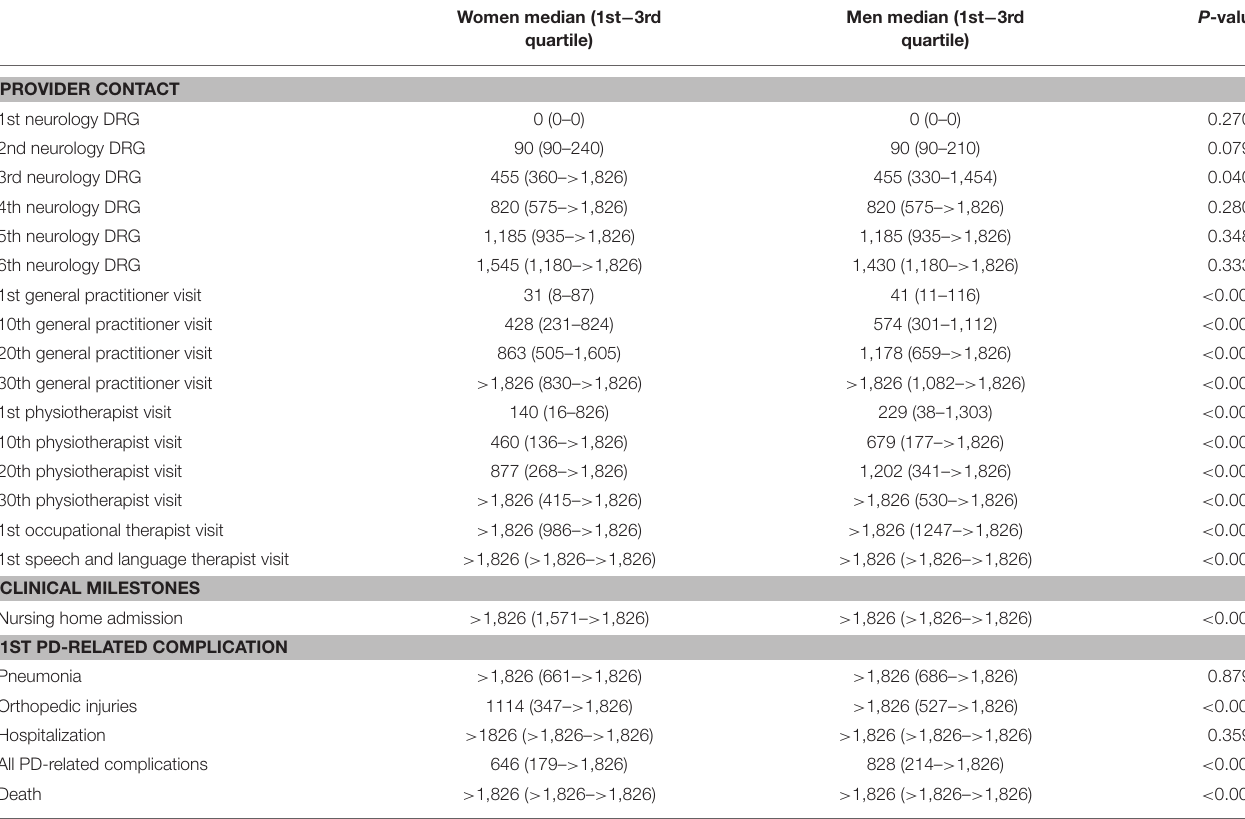
TABLE 2 | Time (in days, since diagnosis) till relevant provider contacts and clinical milestones during the patient journey, by